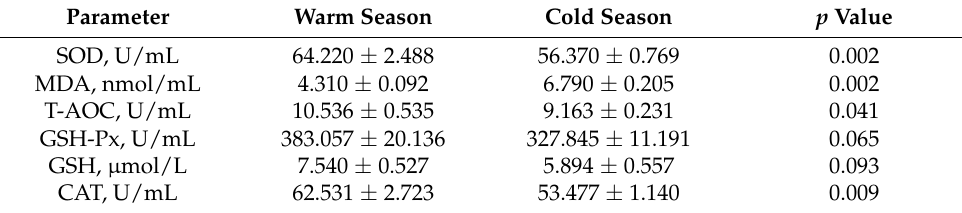
Table 6. Changes in serum antioxidant-related parameters in grazing Mongolian